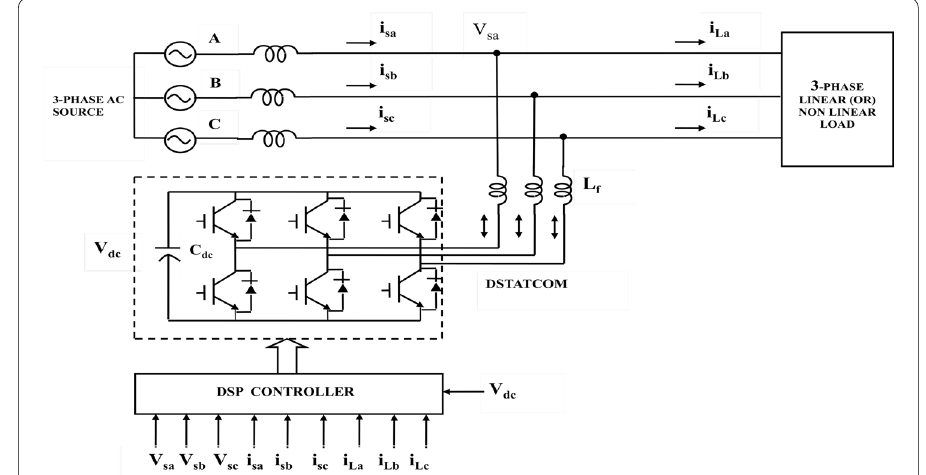
Fig.1 Control block diagram of DSTATCOM